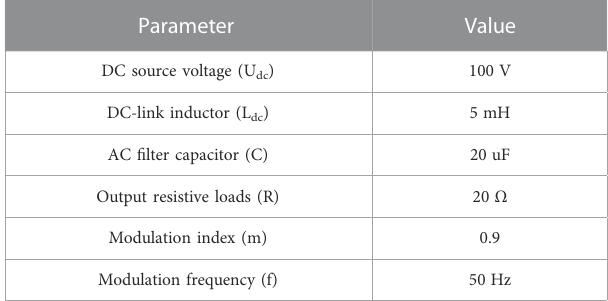
TABLE 2 Simulation